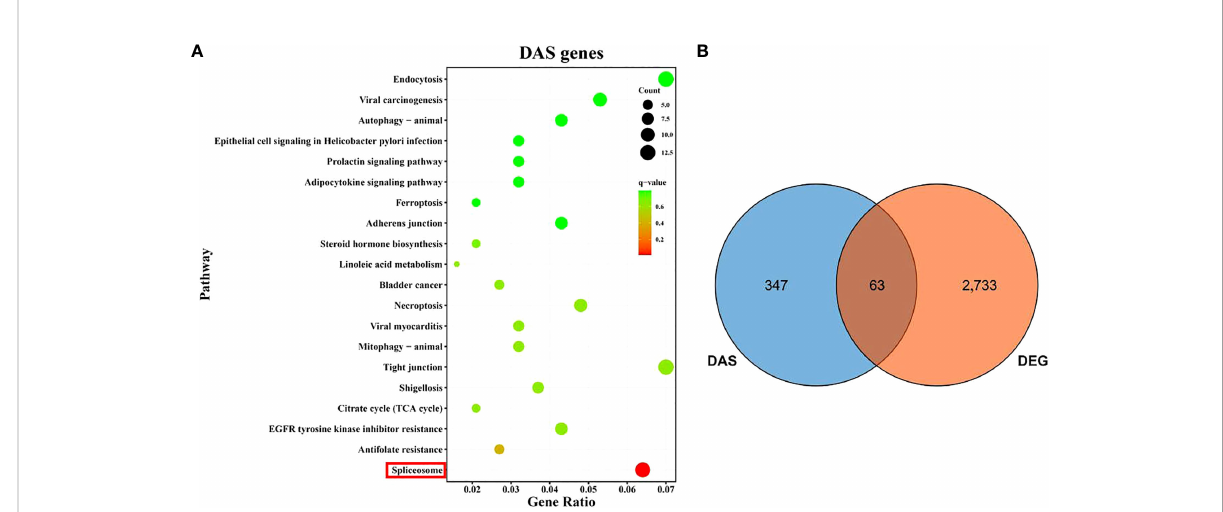
FIGURE 6 An overview of differential alternative splicing (DAS) events in gills of spotted sea bass after hypoxia. (A) KEGG enrichment analysis of DAS genes. (B) Venn diagram showing the overlap of DEGs and DAS